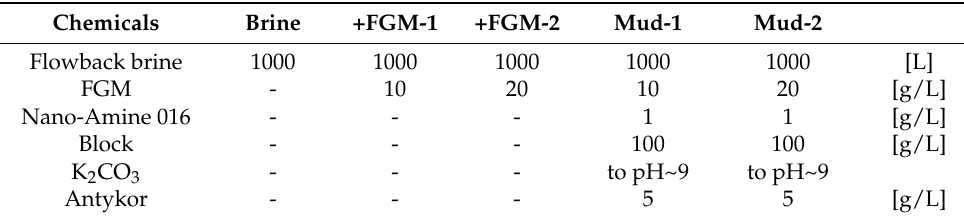
Table 3. Chemical composition of the tested